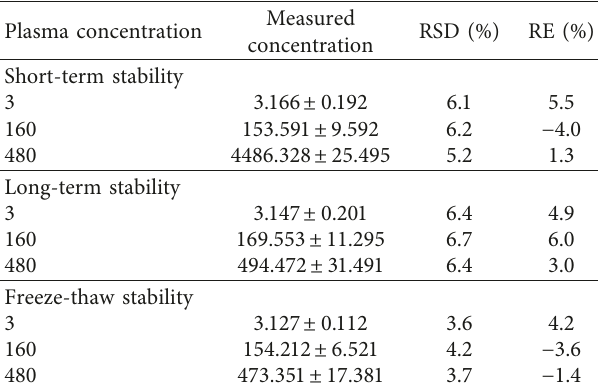
Table 4: Stability of MG-Na in rat plasma ( x ± s ng/mL). Plasma